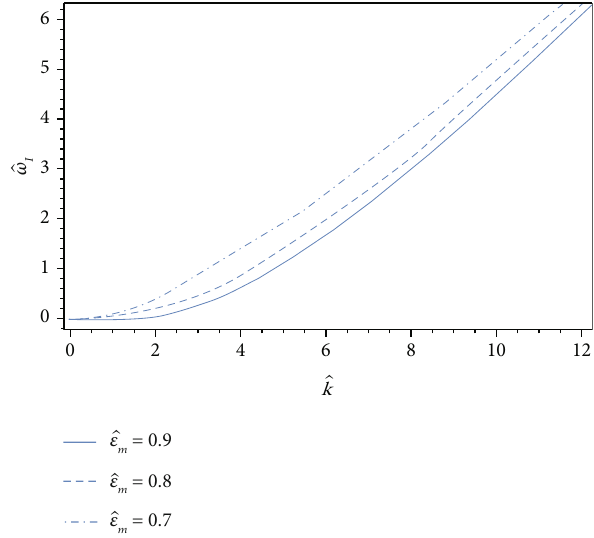
Figure 9: E ff ect of magnetic permeability ratio of two fl uids on growth rate curves at b ρ = 0 : 002 , b μ ′ = 0 : 5 , b μ = 0 : 03 , L = 0 : 3 , = 3 , Ce = 6 , and Oh = 100 0 : 3 , ̂ H = 20 , Ce 2 1